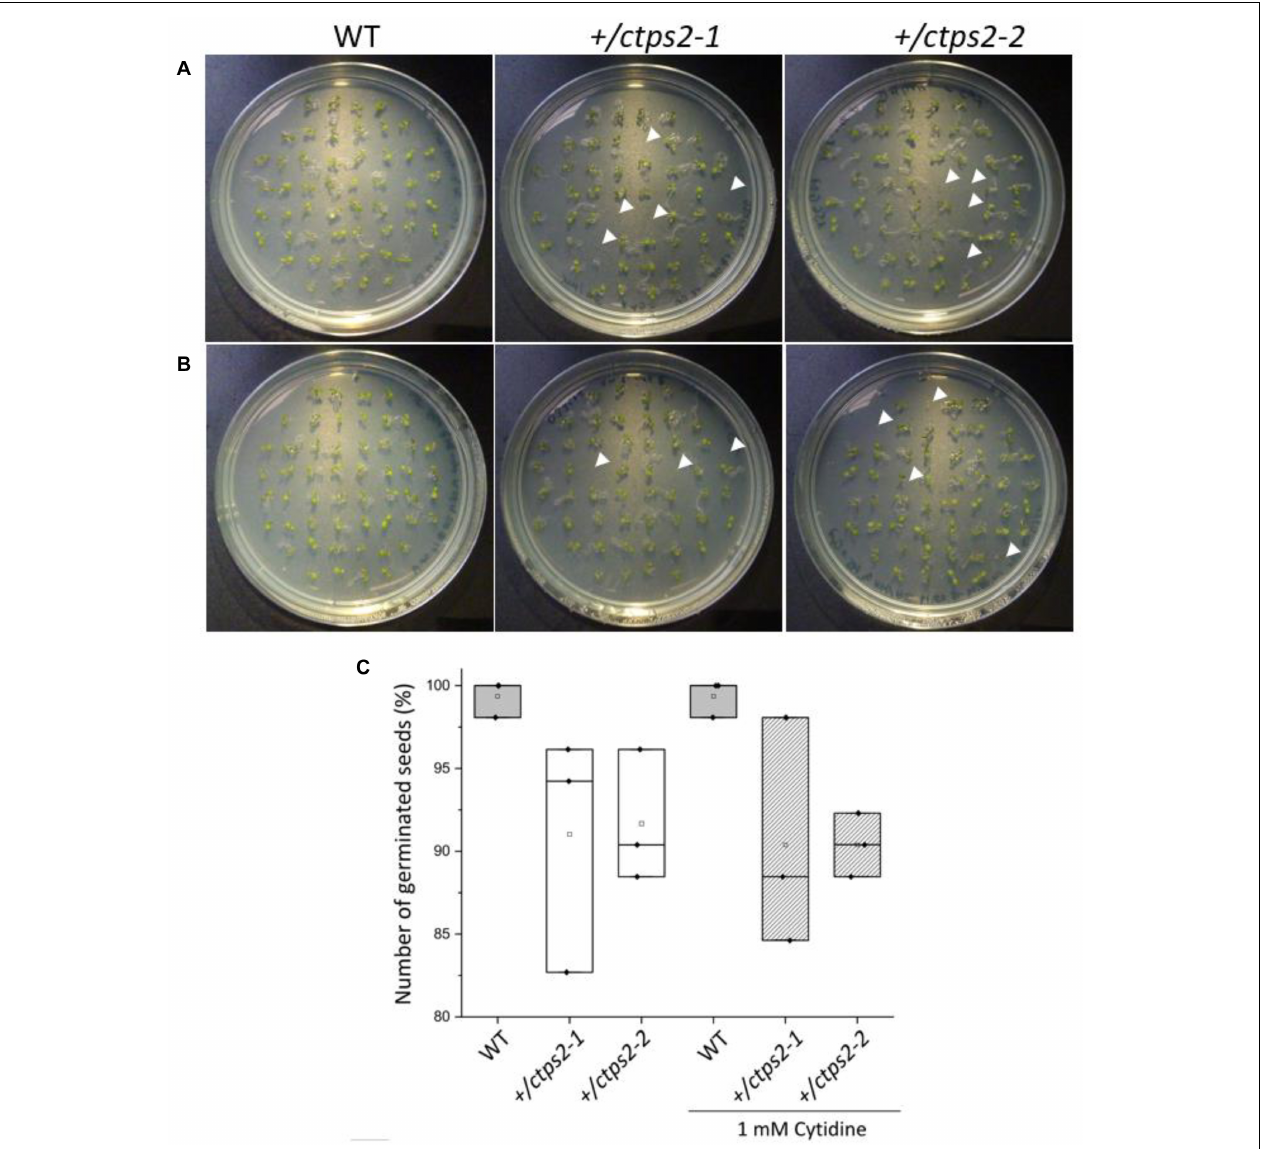
FIGURE 1 | Germination of +/ctps2 lines on 1/2 MS agar plates. Wild-type (WT) and +/ctps2 seeds were placed on (A) 1/2 Murashige–Skoog (MS) agar plates or (B) on plates supplemented with 1 mM cytidine. White arrowheads indicate non-germinated seeds 5 days after transferring to growth chambers. (C) number of germinated seeds with and without application of 1 mM cytidine. A total of 52 seeds were plated for each genotype, and the experiment was repeated three